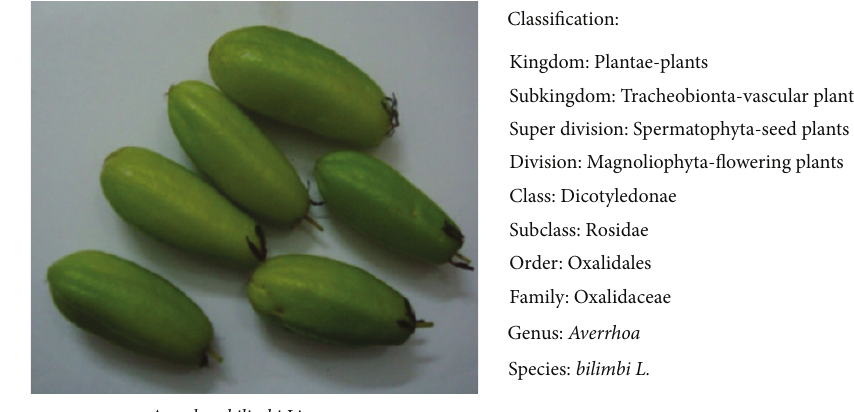
Figure 1: Snapshot showing the fruits of A. bilimbi